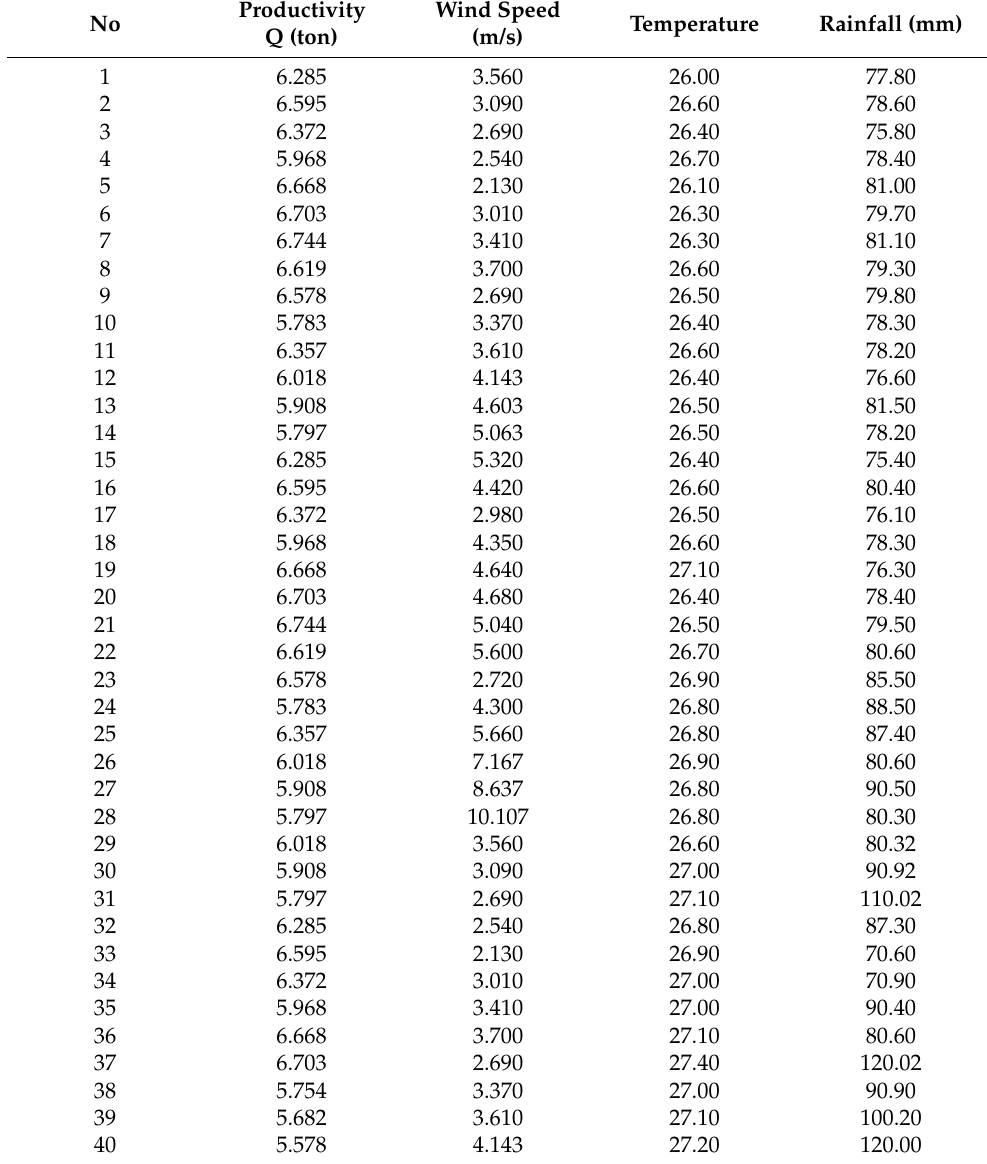
Table A1. Rice productivity data and weather in Bandung Regency, West Java from